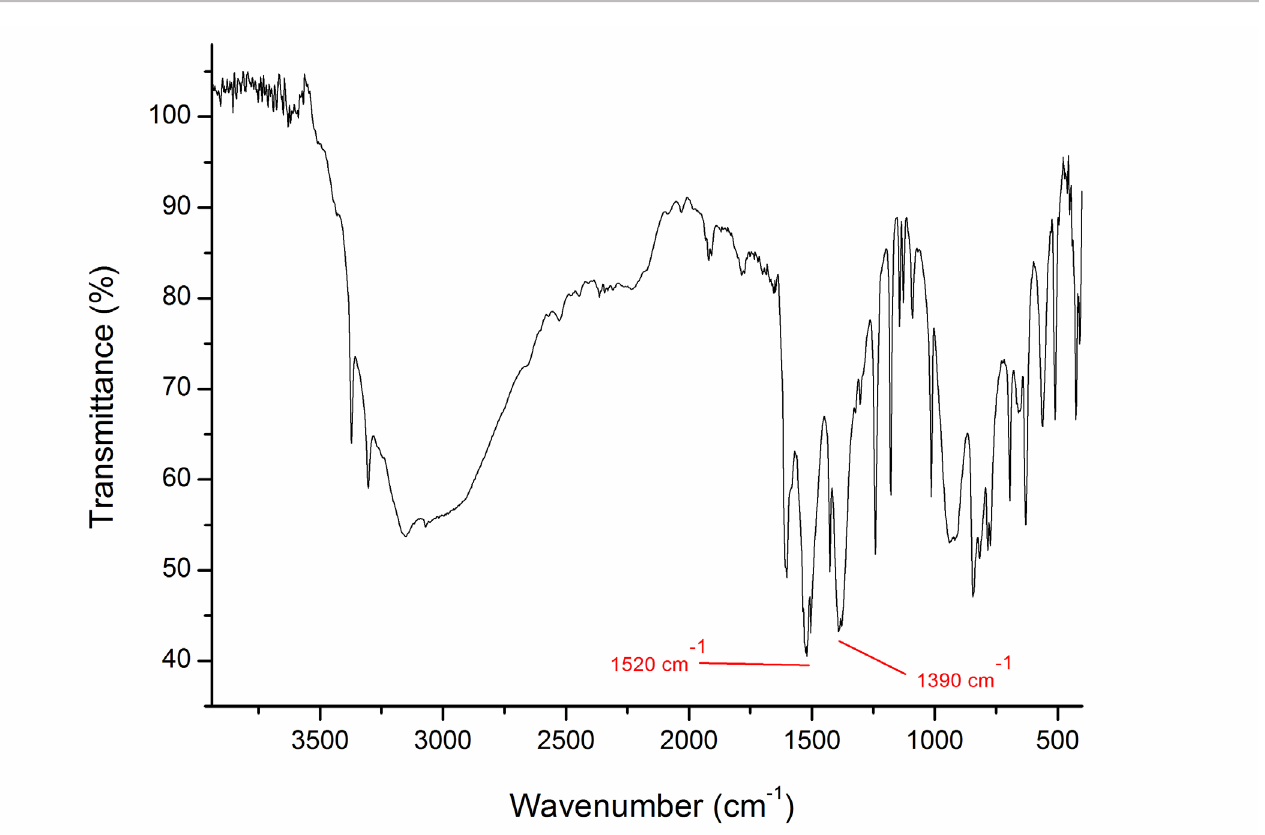
FIGURE 3 – FT-IR spectrum of catena -poly-{[trans(diaqua- kO )cobalt(II)]-bis( m - p -aminobenzoato- k²O,O’ )}.